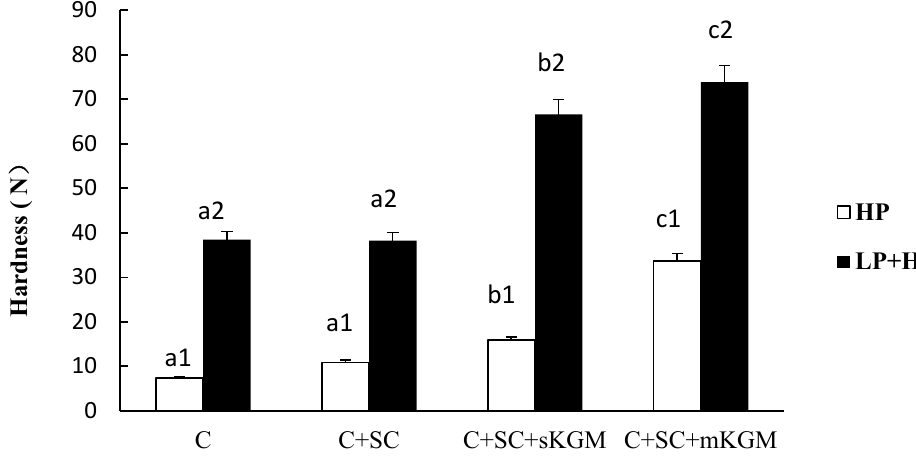
Figure 1. Effects of addition of various levels of SC and KGM on the hardness of different gels. Different numbers (1 or 2) in the same sample indicate significant differences ( p < 0.05) among all treatments. Different letters (a, b, c or d) in the same batch indicated significant differences ( p < 0.05) among the sample. The Figures 1–5 were the same.